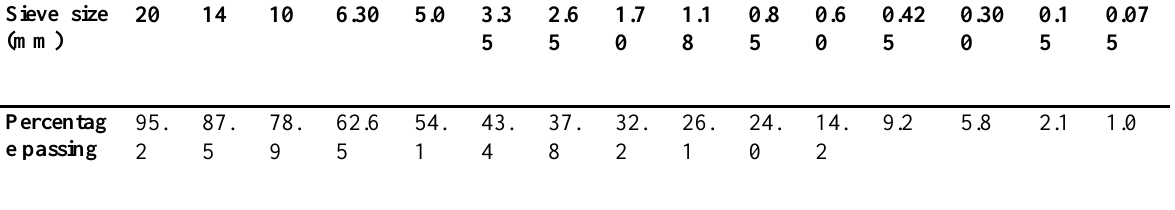
Percentage Passing Some BS Sieves Diameters. Sieve